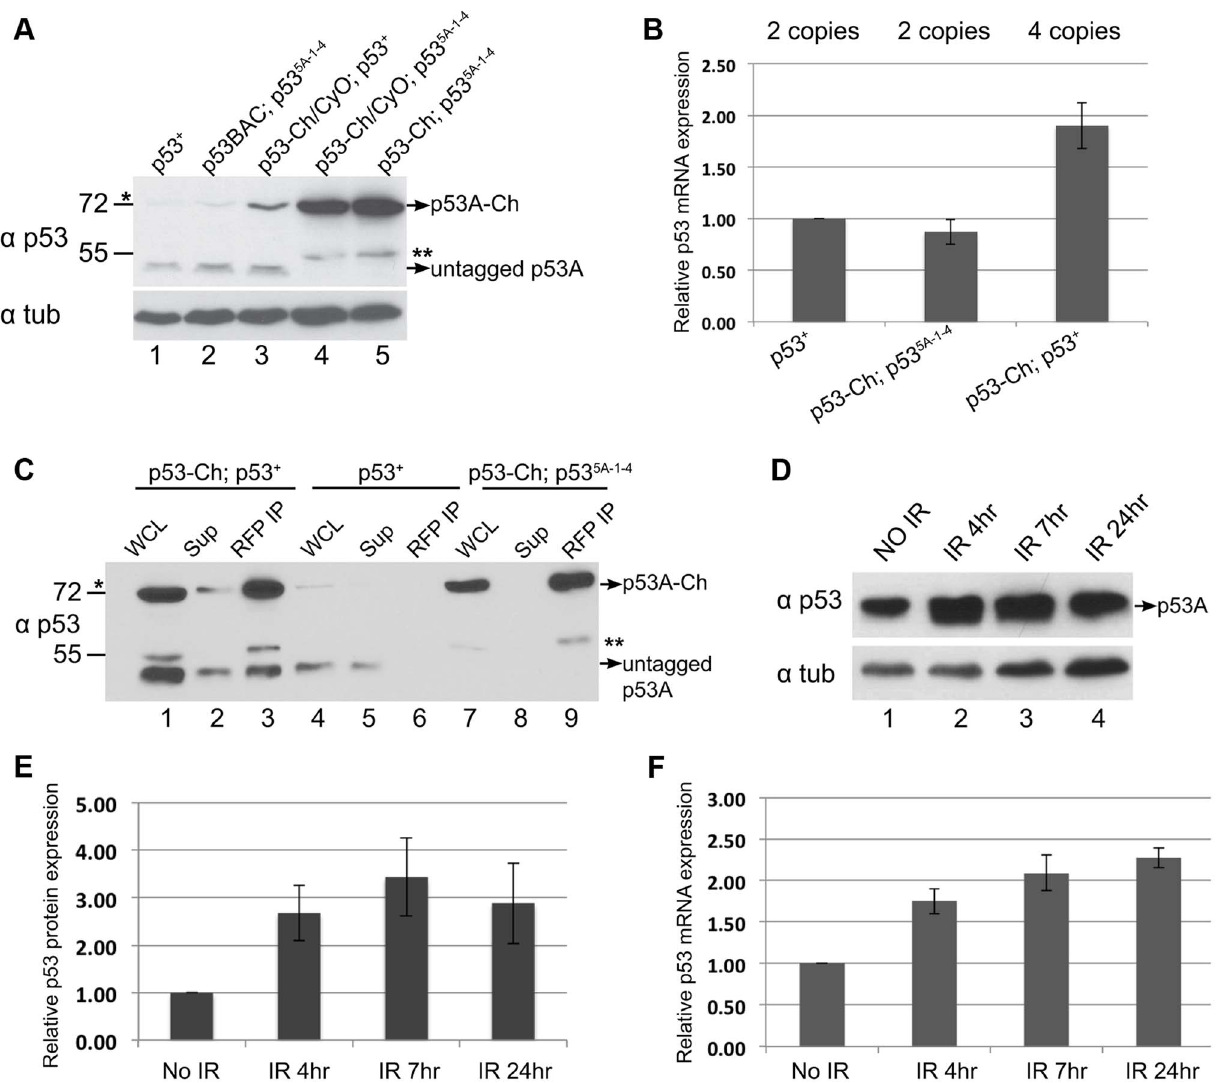
Figure 6. p53 protein complex turnover in mitotic cycling cells. (A) The mCherry tag increases p53-Ch protein in p53 mutant but not wild type mitotic cycling cells. Western blot with anti-p53 to detect endogenous and mCherry-tagged p53 (p53-Ch) protein in 3 rd instar B–D extracts. Lane 1: Wild type. Lane 2: Two copies of untagged, wild type p53 BAC transgene in a p53 null mutant background. Lane 3: One copy p53-Ch in a p53 wild type background. Lane 4: One copy p53-Ch in a p53 null background. Lane 5: Two copies p53-Ch in a p53 null background. * indicates a faint non- specific band at , 72 kDa. ** indicates a degradation product from p53-Ch. Loading control: Anti-alpha Tubulin. (B) RT-qPCR quantification of p53 mRNA expression levels in p53 + or p53-Ch; p53 5A-1-4 or p53-Ch; p53 + fly strains. The number of copies for p53 gene is indicated above each genotype. After normalizing to Act5C, the mRNA levels in p53 + were defined as 1. Error bars represent S.E.M from three independent biological replicates. (C) p53-Ch associates with endogenous p53. RFP-nanobody IP from 3 rd instar B–D extract of the indicated genotypes followed by Western blot with anti- p53. Lane 1,4,7: whole cell extract (WCL), Lane 2,5,8: supernatant (sup) after IP depletion. Lane 3,6,9: IP pellet. * indicates a faint non-specific band at , 72 kDa. ** indicates a degradation product from p53-Ch. (D) p53 protein level in mitotic cycling B–D cells increases several fold after IR. Western blot with anti-p53 to detect endogenous p53 in 3 rd instar B–D extracts prepared at different time points after IR. Loading control: Anti-alpha Tubulin. (E) Quantification of p53 protein level change in B–D cells at different time points following IR. After normalizing to loading control alpha-tubulin, p53 protein levels from the No IR control was defined as 1. Error bars represent S.E.M from three independent biological replicates. (F) RT-qPCR quantification of p53 mRNA expression level changes following IR. After normalizing to Act5C, p53 mRNA level from No IR sample was defined as 1. Error bars represent S.E.M from three independent biological replicates. promoters in the absence of stress, which may prepare cells for a rapid apoptotic response to DNA damage. In addition, our data suggest that p53A protein levels are regulated in mitotic cycling cells, which likely ensures that apoptosis occurs only in response to stress. Together, our results have revealed new mechanisms by which different cells in development modulate their apoptotic response.